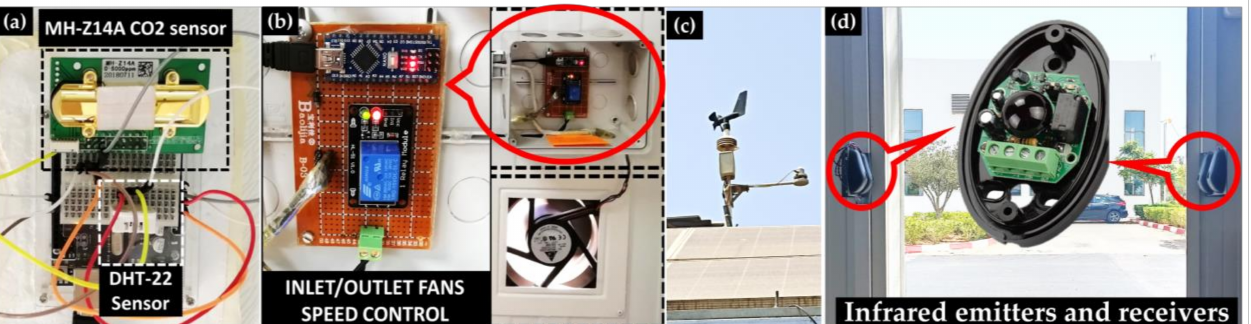
Figure 3. The deployed IoT devices; ( a ) Indoor CO 2 , temperature and humidity node; ( b ) Inlet and outlet ventilator speed control node; ( c ) Weather station node for outdoor air quality; ( d ) Occupants’ number